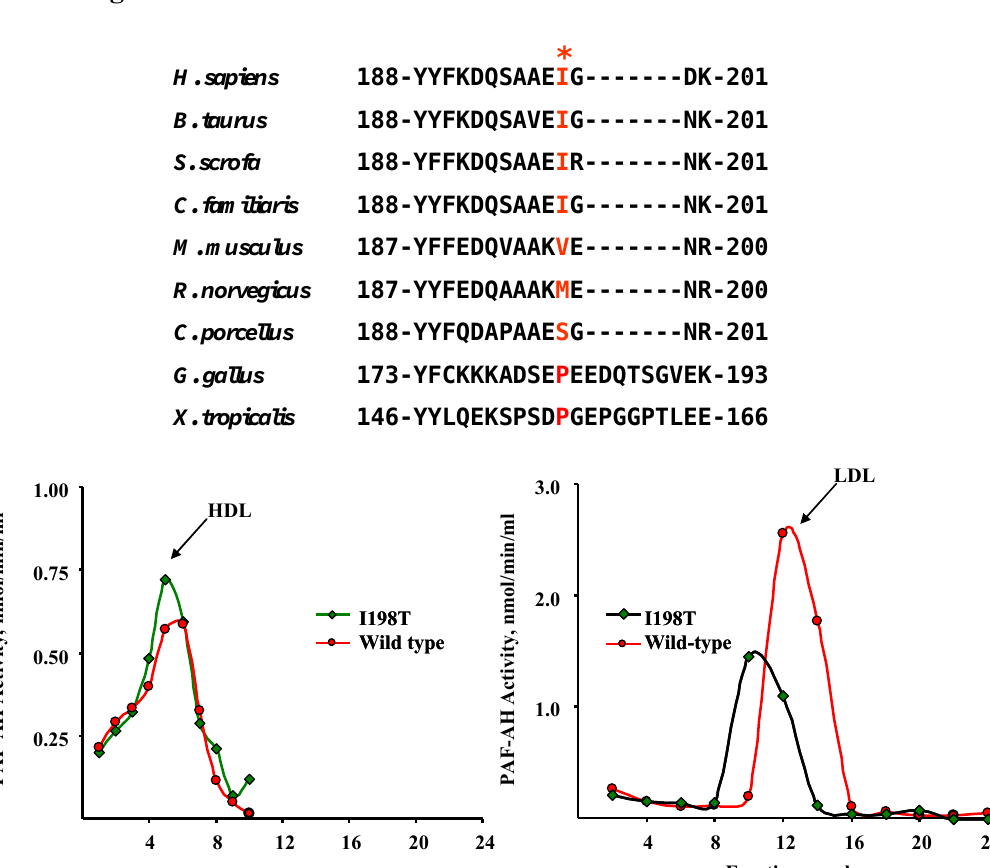
Figure 3. The I198T variant binds to human HDL and LDL in vitro.